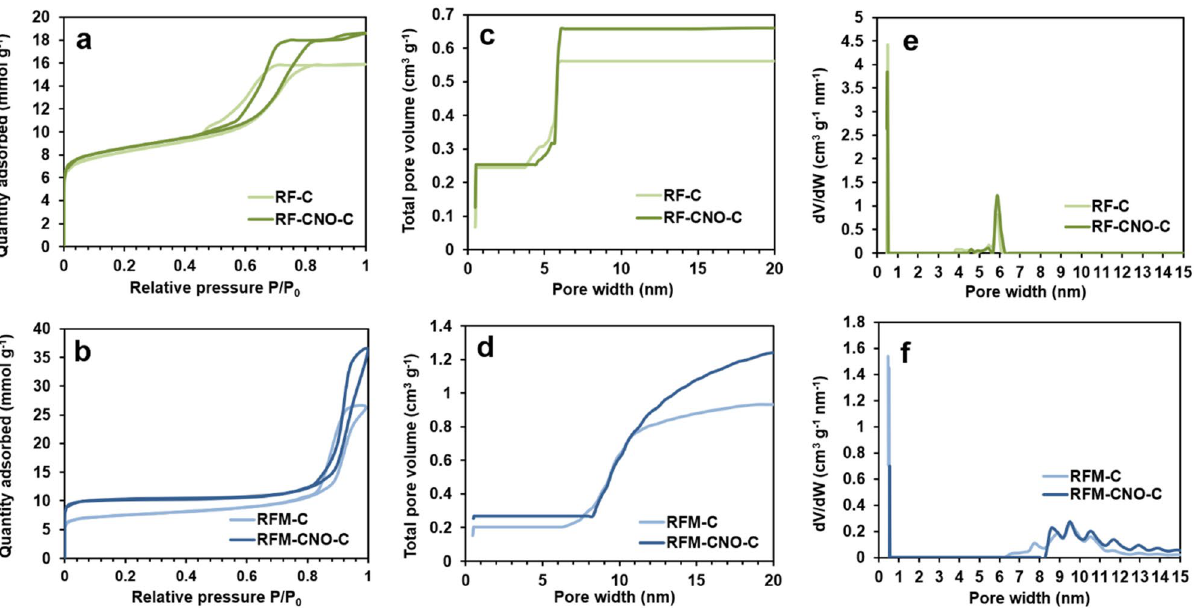
Figure 8. ( a , b ) N 2 adsorption–desorption isotherms and ( c , d ) cumulative and ( e , f ) differential PSD of RF-C , RF-CNO-C , RFM-C , and RFM-CNO-C materials.